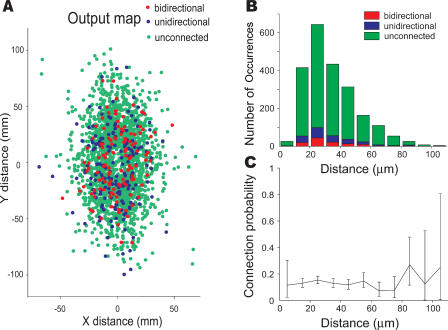
Probability of Connection among Adjacent Neurons Does Not Depend Strongly on the Interneuron Distance(A) Relative location of labeled neurons in the plane of the section. Positive direction of y-axis is aligned with apical dendrite. Potentially presynaptic neuron is located at the origin. Red—bidirectionally connected pairs; blue—unidirectionally connected pairs; green—unconnected pairs.(B) Histogram showing the numbers of pairs in the three classes as a function of distance between neurons (Euclidian distance was calculated from relative X, Y, Z coordinates).(C) Probability of connection versus interneuron distance. Error bars are 95% confidence intervals estimated from binomial distribution.